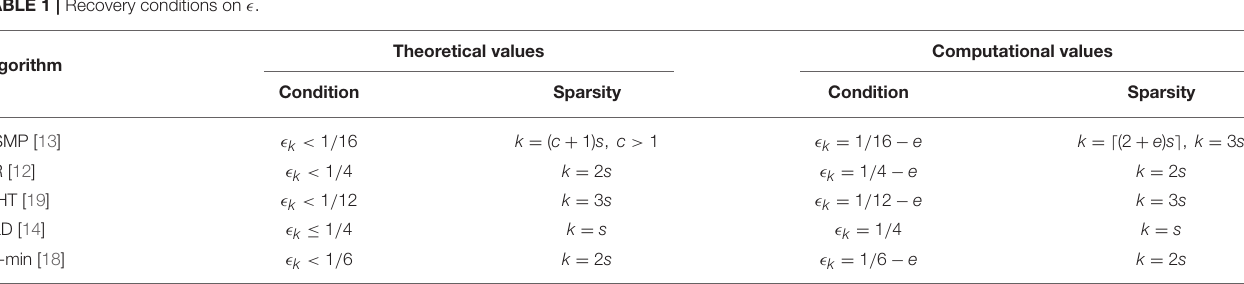
10 − 15 , c n 2 and δ 10 − 6 ,1 on a = = ∈ h i